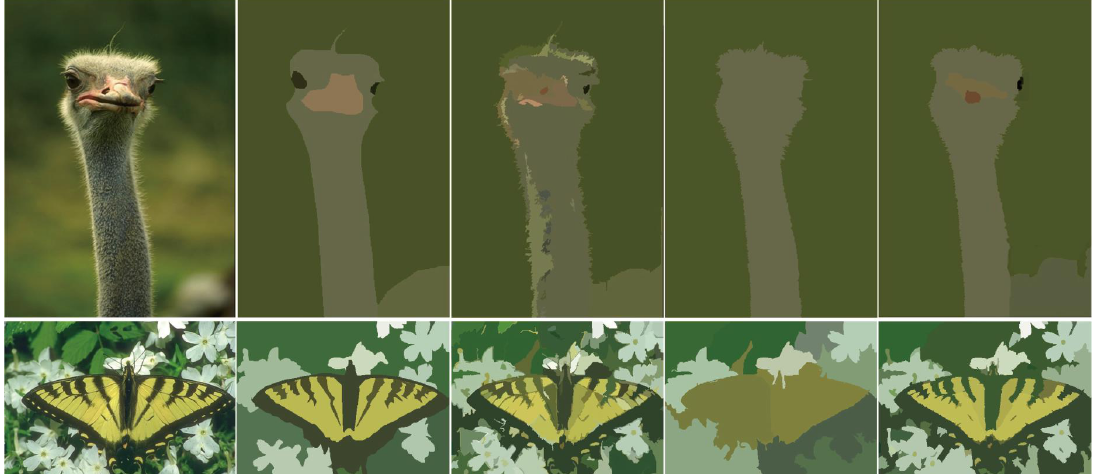
Fig. 3. Visual effect comparison with different algorithms on BSDS500 dataset. Column 1 and 2 are the test image and Ground Truth image respectively. Column 3 to 5 are the segmentation results of FH, Bipartite Graph and the